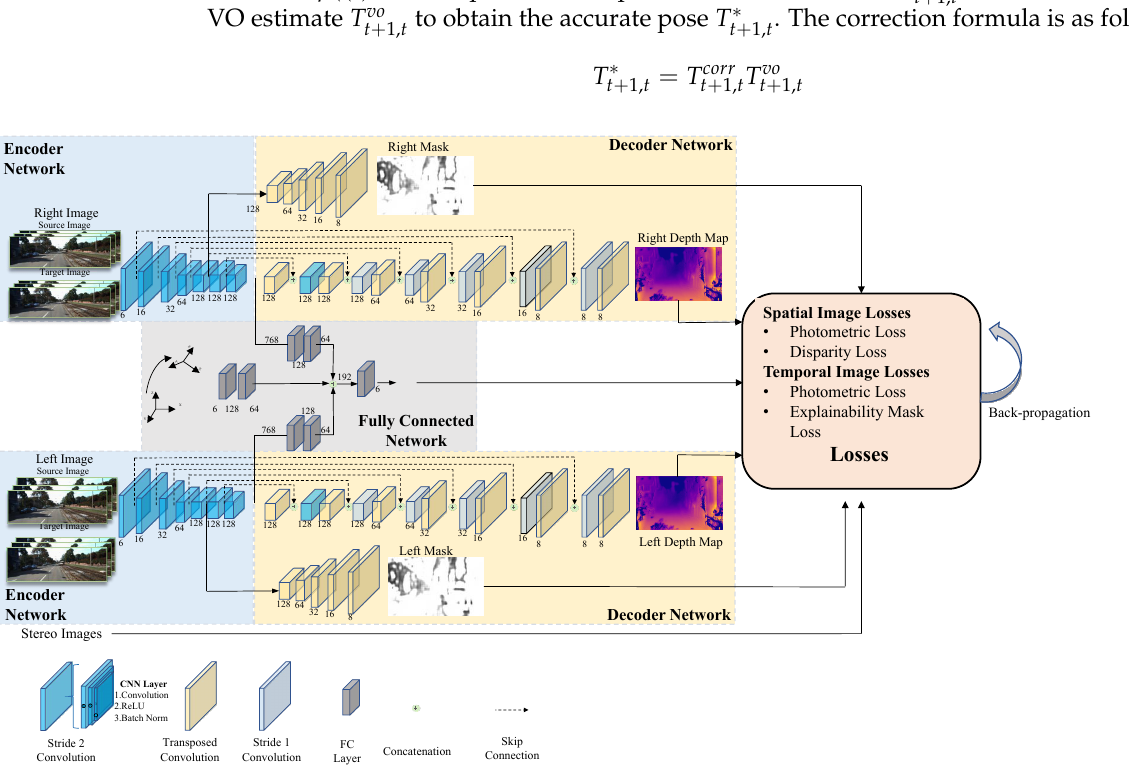
Figure 2. Training scheme of the proposed unsupervised stereo visual odometry pose correction network. The whole network consists of an encoder network, decoder network, and a fully connected network. The encoder network comprises five parts, and each part comprises a 2D convolution layer with stride 2, a ReLu activation layer, and a batch normalization layer. We do not use the pooling layer after the convolution layer because the pooling